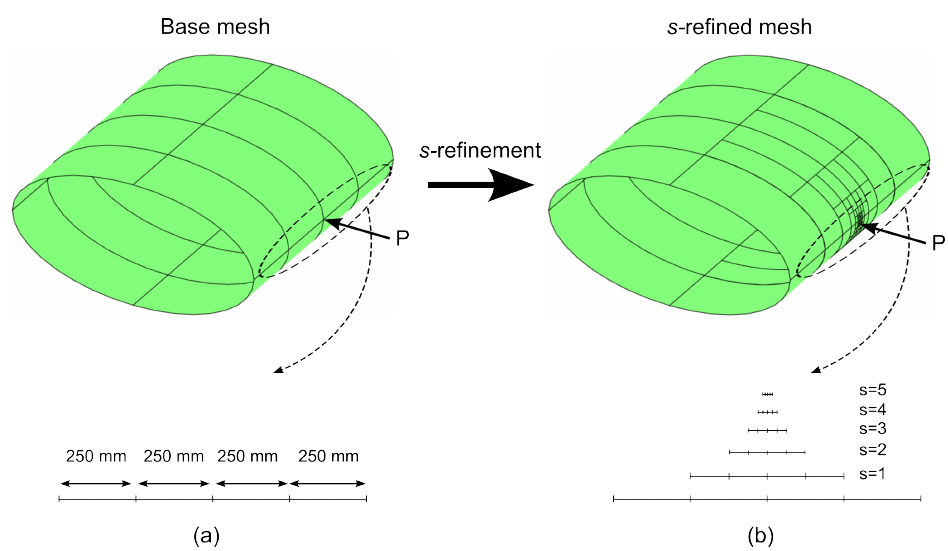
Figure 19. Variable Stiffness cylindrical elliptical shell – static analysis: ( a ) Base mesh, ( b ) s − refined mesh. The plots of the out − of − plane displacement w and the stress component σ 22 on the out- most ply at ξ 2 = 3/2 π are illustrated in Figure 20. Similar results are obtained for the two models in terms of deflections, as shown in Figure 20a.